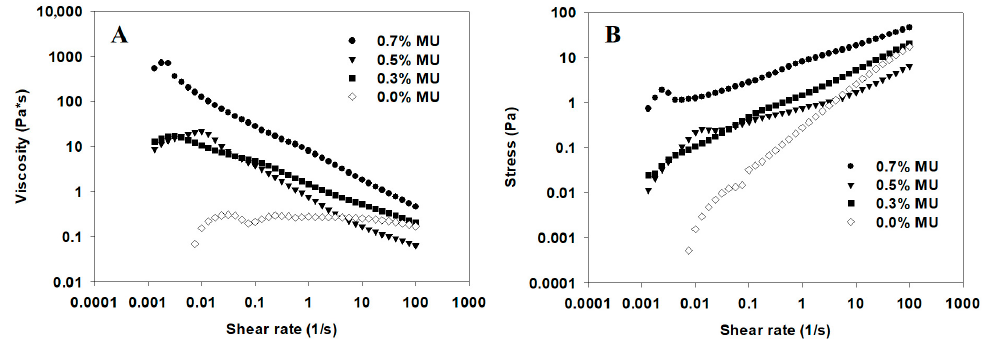
Figure 1. Rheological properties: ( A ) shear rate vs. viscosity and ( B ) stress vs. shear rate at different concentrations of mucilage–alginate.